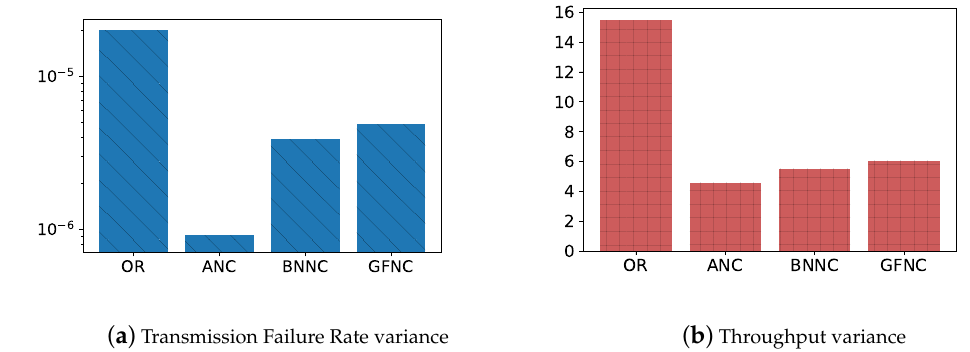
Figure 9. The transmission failure rate variances and throughput variances of different schemes in simulations. The variances reflect the fluctuation range of throughput and transmission failure rate for different network coding schemes when the packet loss rate of wireless link